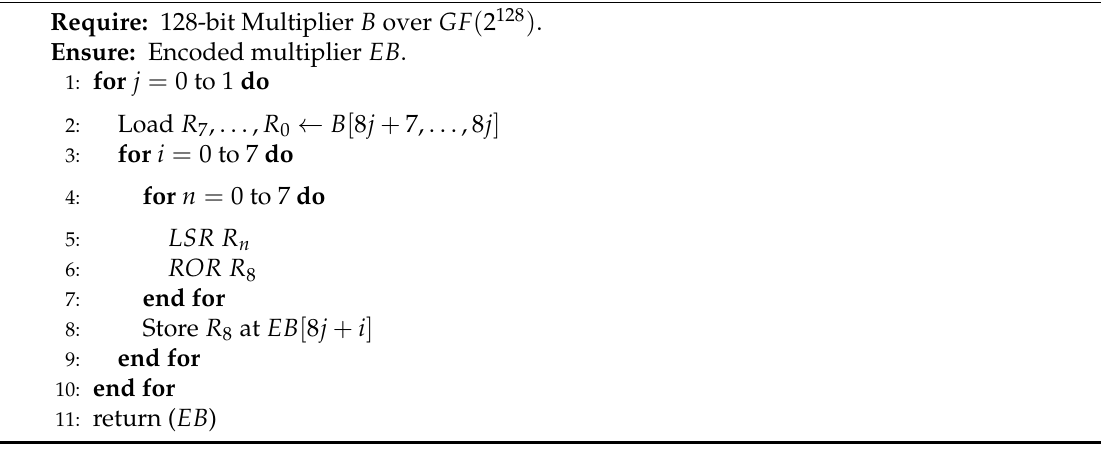
Algorithm 2: 128-bit multiplier encoding technique on 8-bit AVR MCUs.